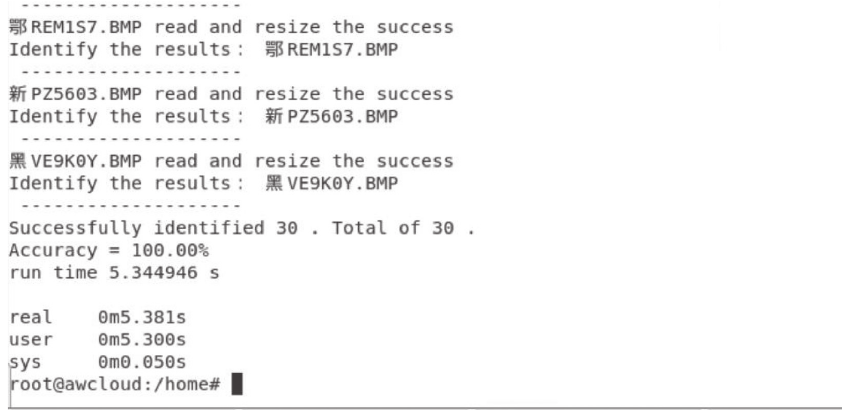
Figure 9: System identification result.